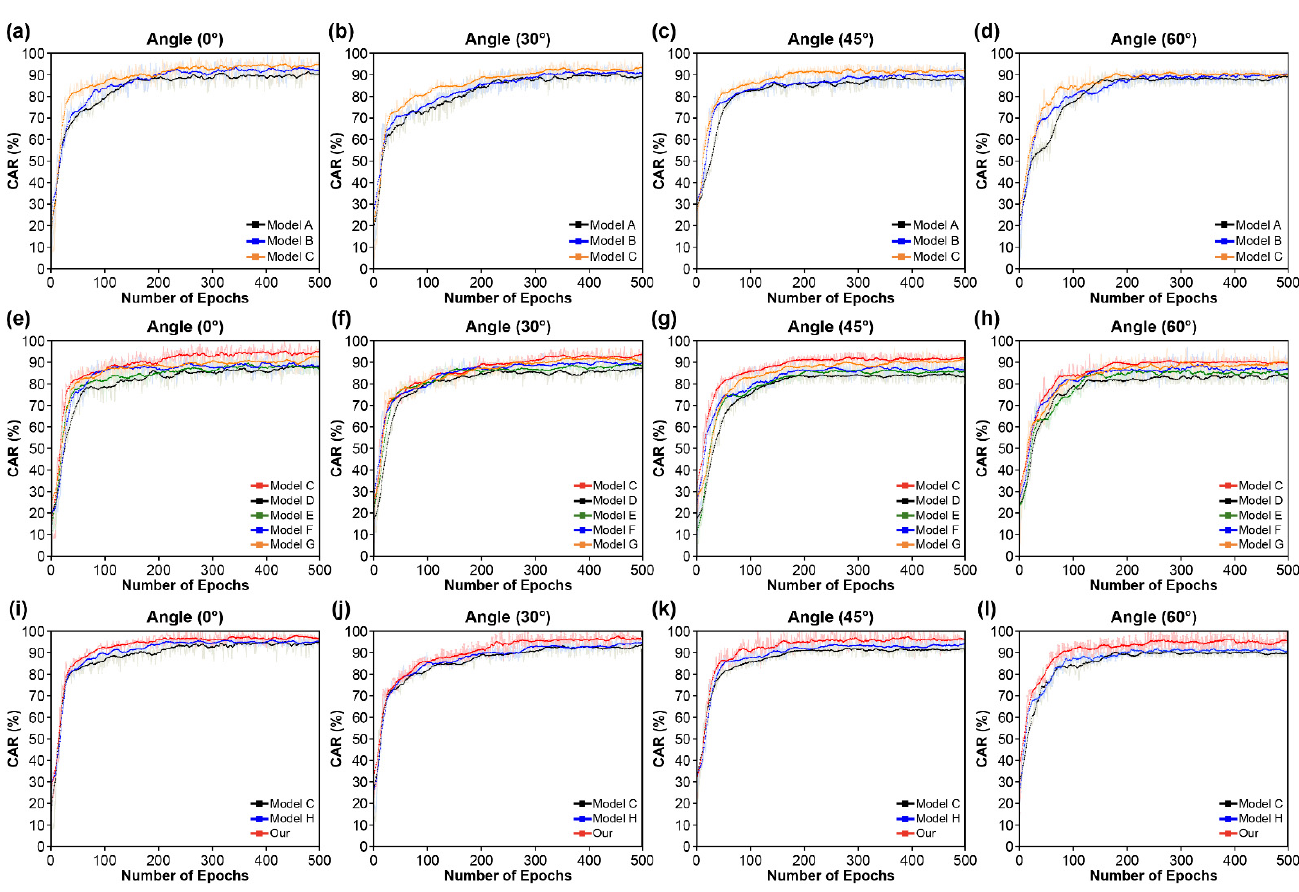
Figure 9. Training steps for character error rate (CER) comparing our proposed model to the baseline and other models: ( a – d ) Convolutional layer; ( e – h ) recurrent layer; ( i – l ) transcription layer.